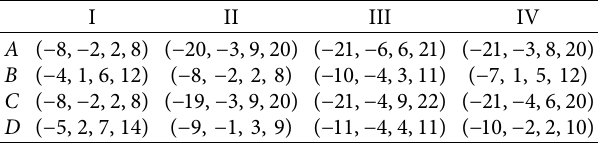
Table 13: Subtract ( − 7, − 2, 4, 14) from uncovered intervals.